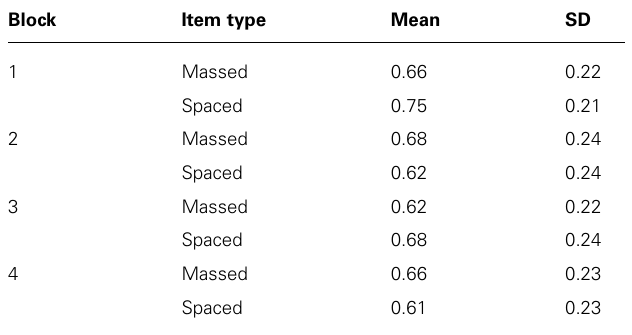
Table 3 | d -prime on the final test as a function of block and item type.